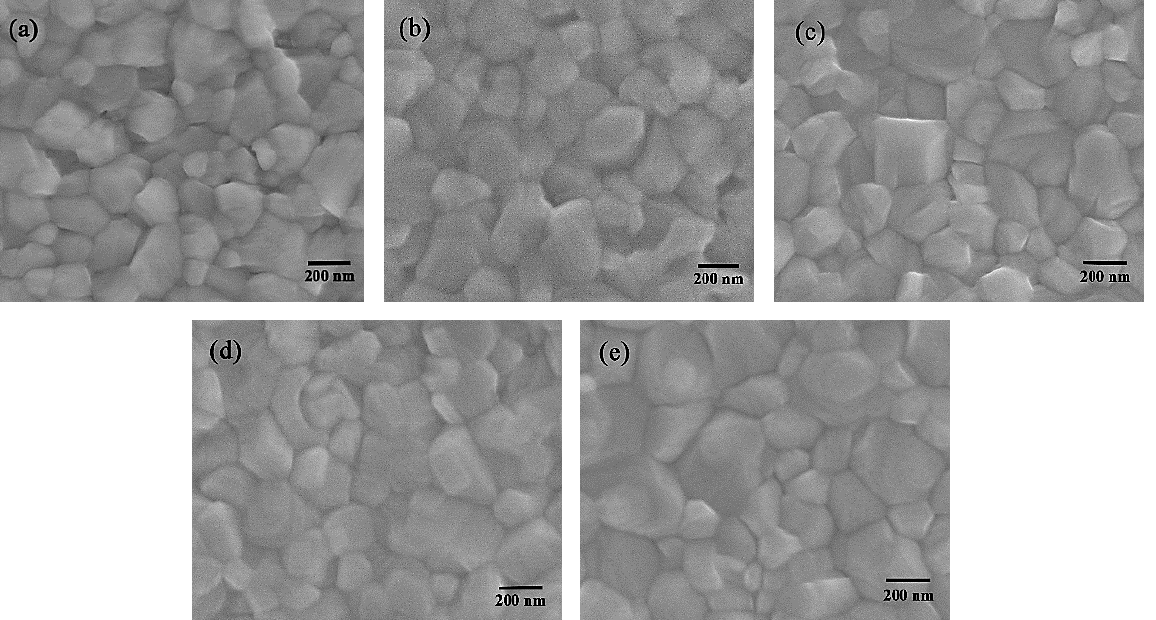
Figure 2. Top-view SEM images of perovskite films with different Ag incorporation: ( a ) 0%, ( b ) 0.5%, ( c ) 1.0%, ( d ) 3.0%, and ( e ) 5.0%.